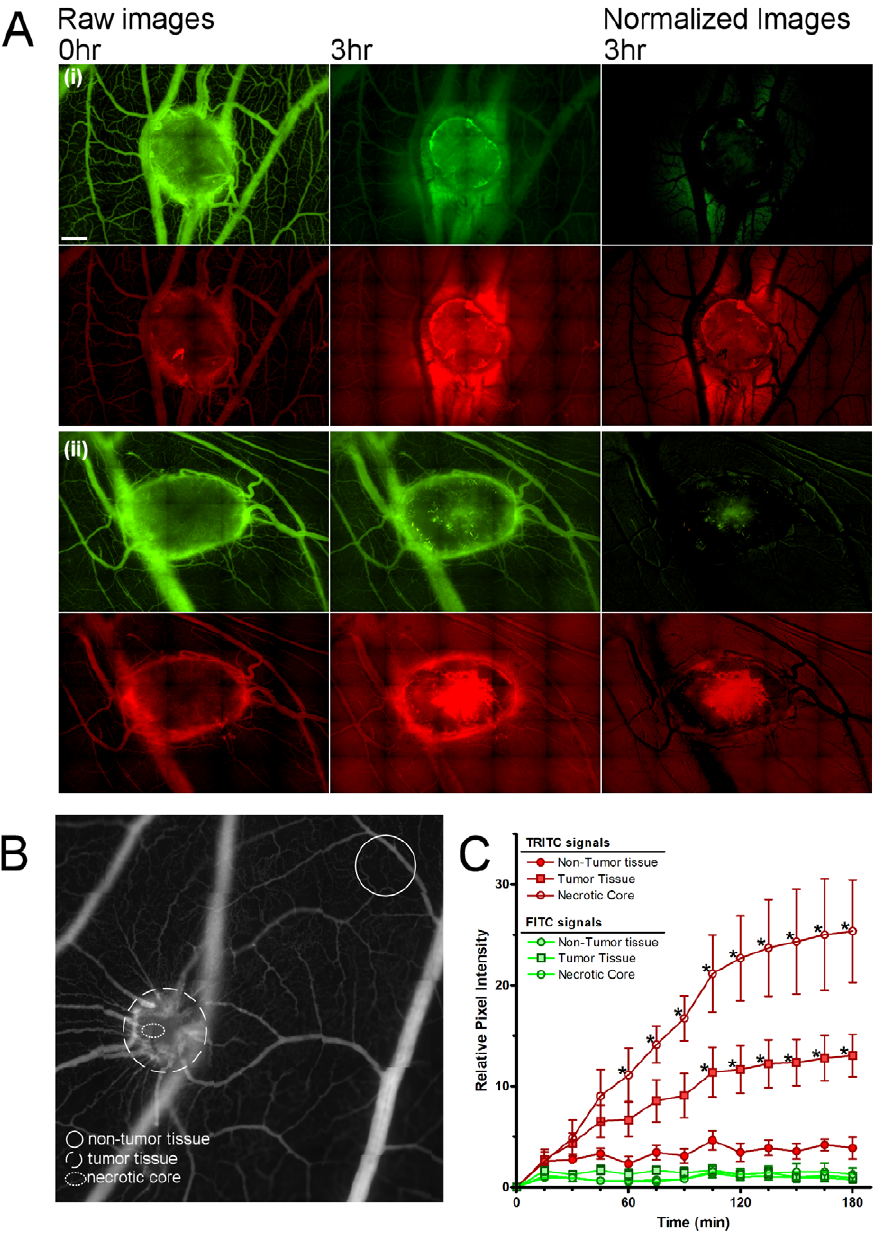
Figure 3. Assessment of regional permeability and vascular integrity in human tumors. A. Representative fluorescence micrographs from two human HEp3 tumors displaying peri-tumoral (i) and tumor core (ii) vascular leak are shown with the 2000 kDa FITC-dextran (green) and 158 kDa TRITC-dextran (red). The normalized images were generated by subtracting the 0 hour image from the 3 hour image, and represent the net vascular leak. Tumor induced vascular leak is localized primarily to the tumor and especially to the central, necrotic core of the tumor. B. Areas utilized for regional vascular leak analyses are delineated. The solid circle represents an area of non-tumor tissue; the dashed circle denotes tumor and the dotted line indicates the avascular necrotic core. C. Quantitation of leak of large (green) and small (red) dextrans is shown for non-tumor tissue, the entire tumor and the core of the tumor. The relative leak of both dextrans was normalized to time zero; n=6 for each analysis. Two-way ANOVA, (p , 0.05) followed by Bonferroni post-tests, (p , 0.05) was used to assess significant leak of the TRITC-dextran of either tumor versus non-tumour tissue, and necrotic core versus non-tumour tissue at each timepoint. Timepoints that demonstrated significance are indicated by an asterisk.